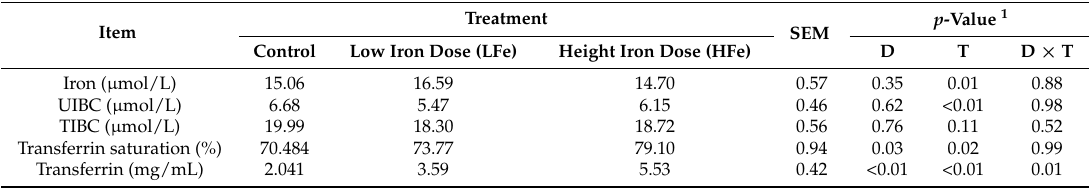
Table 2. Mean value of iron metabolism parameters.